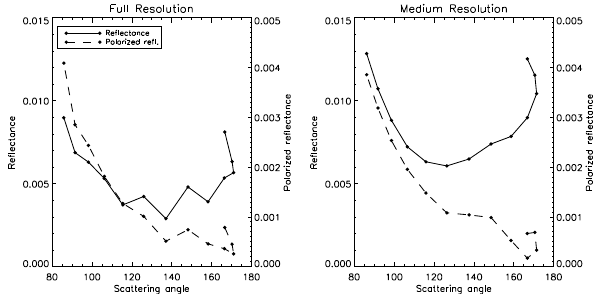
Figure 6. A typical PARASOL observation (in the 865nm band) that is affected by stereo effects. While there are no clouds detected by MODIS directly above the full-resolution PARASOL pixel, there are a few clouds roughly 4km away. These are included in the medium-resolution PARASOL pixel of which the observation is shown in the panel on the